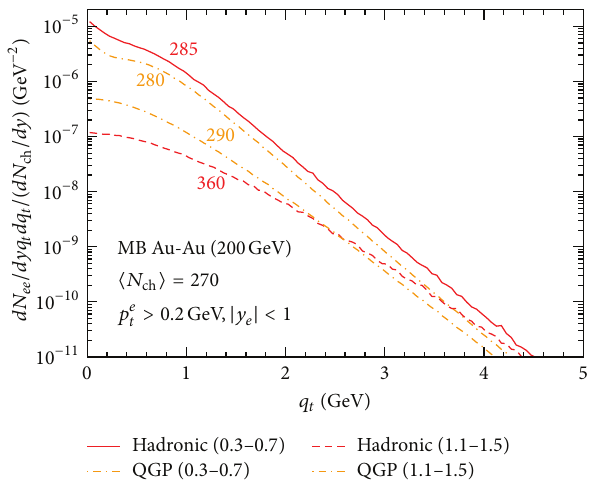
Figure 6: Dilepton transverse-momentum spectra from thermal radiation of QGP and hadronic matter in MB Au-Au(200 AGeV) collisions. The numbers next to each curve indicate the effective (MeV), as extracted from a two parameter fit slope parameter, 𝑇 eff ] [45] with the transverse mass using 𝑑𝑁/(𝑞 𝑡 𝑑𝑞 𝑡 ) = 𝐶 exp [−𝑀 𝑡 /𝑇 eff = √𝑀 2 + 𝑞 2 𝑀 𝑡 𝑡 and an average mass of 0.5 GeV and 1.25 GeV for the low- and intermediate-mass windows,